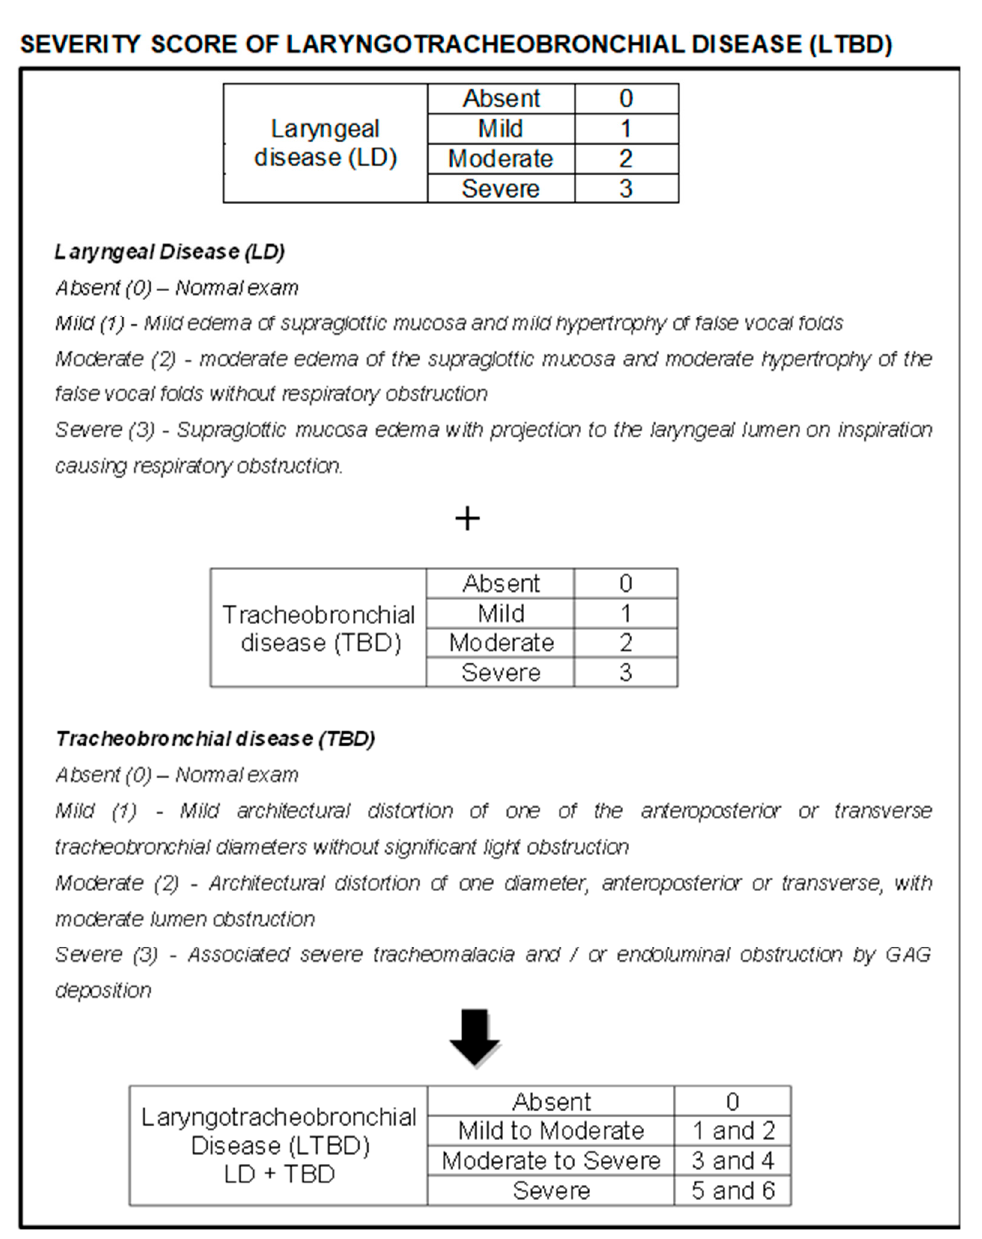
Figure 1. Classification of laryngotracheobronchial disease in mucopolysaccharidoses